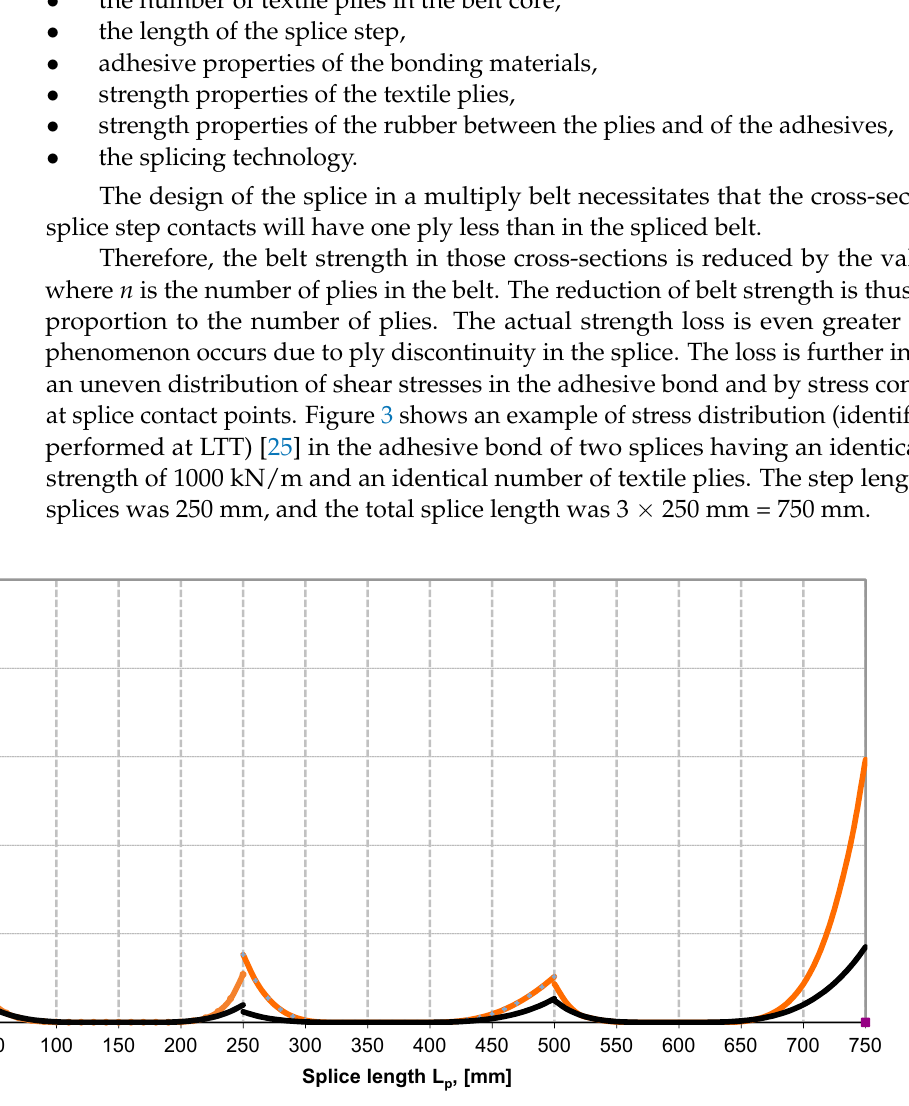
Figure 3. Shear stress distribution τ along the total splice length L p . Splice in belt type EP 1000/4 (black), splice in belt type P 1000/4 (orange) [25].